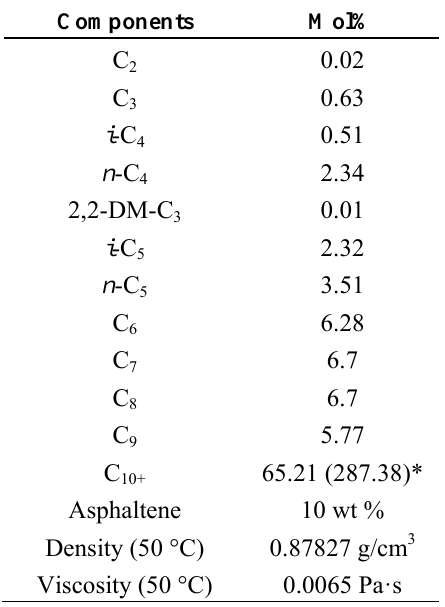
Table 3. Crude oil